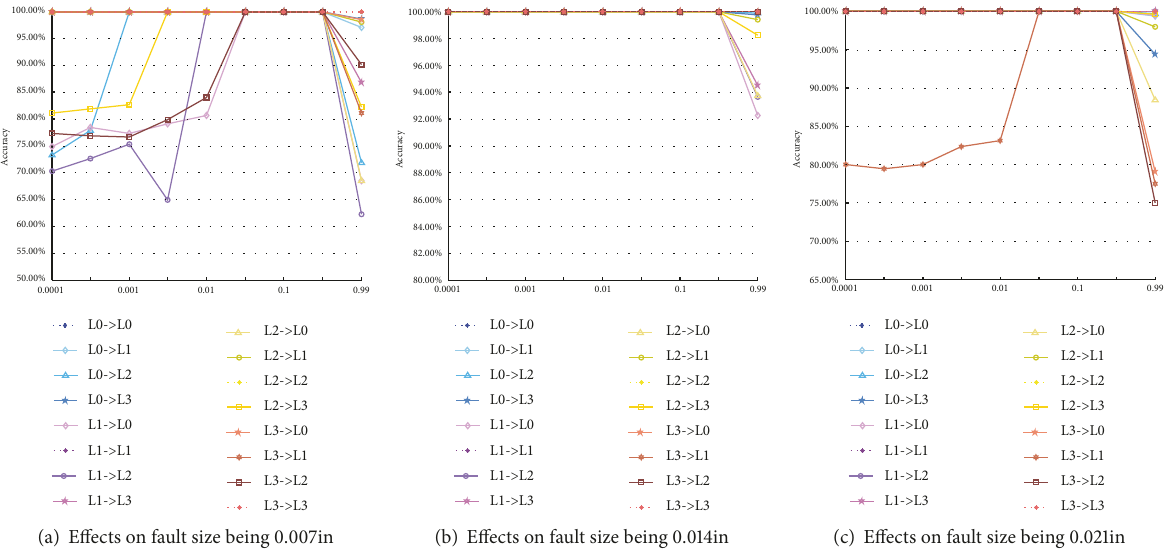
Figure 9: Accuracy (%) on different 𝜆